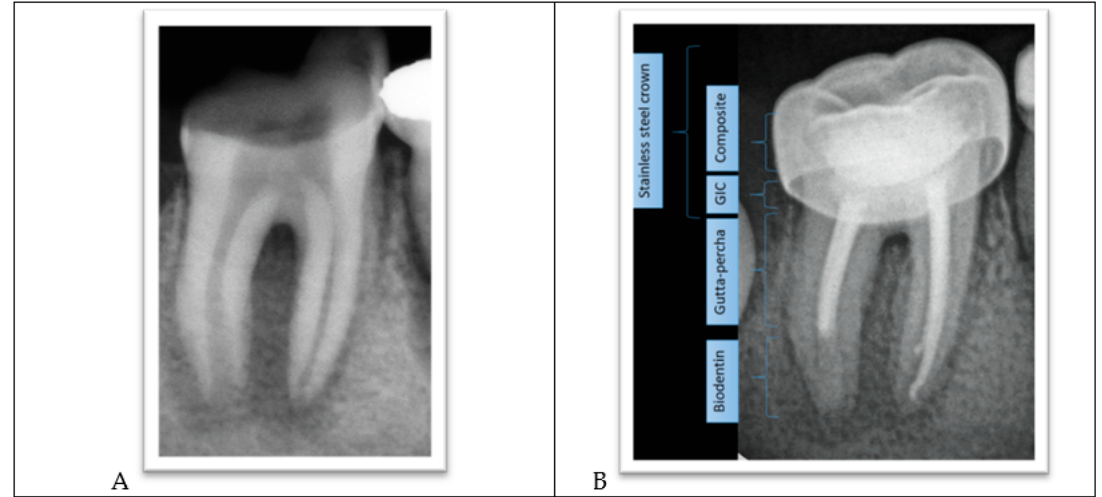
Figure 5. ( A ) Apical lesions with extensive decay in tooth #46. ( B ) Biodentine placement, completed root canal treatment, and placement of a metallic crown.